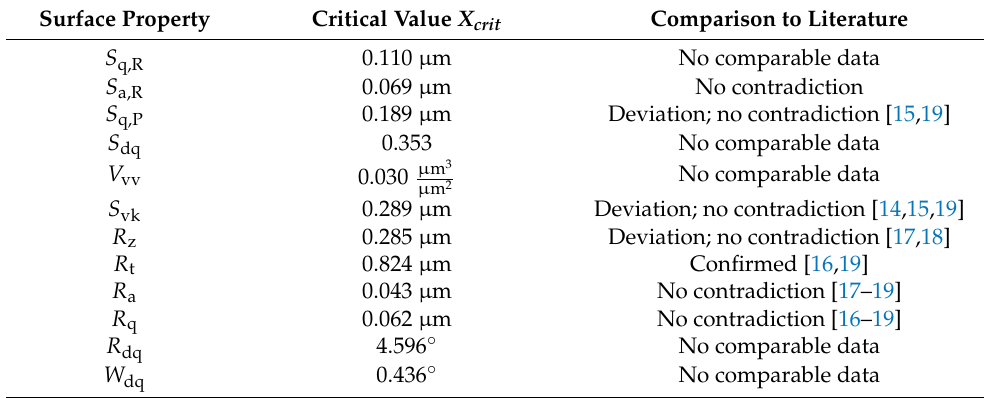
Table 4. Summary of critical values for corrugations for the respective surface